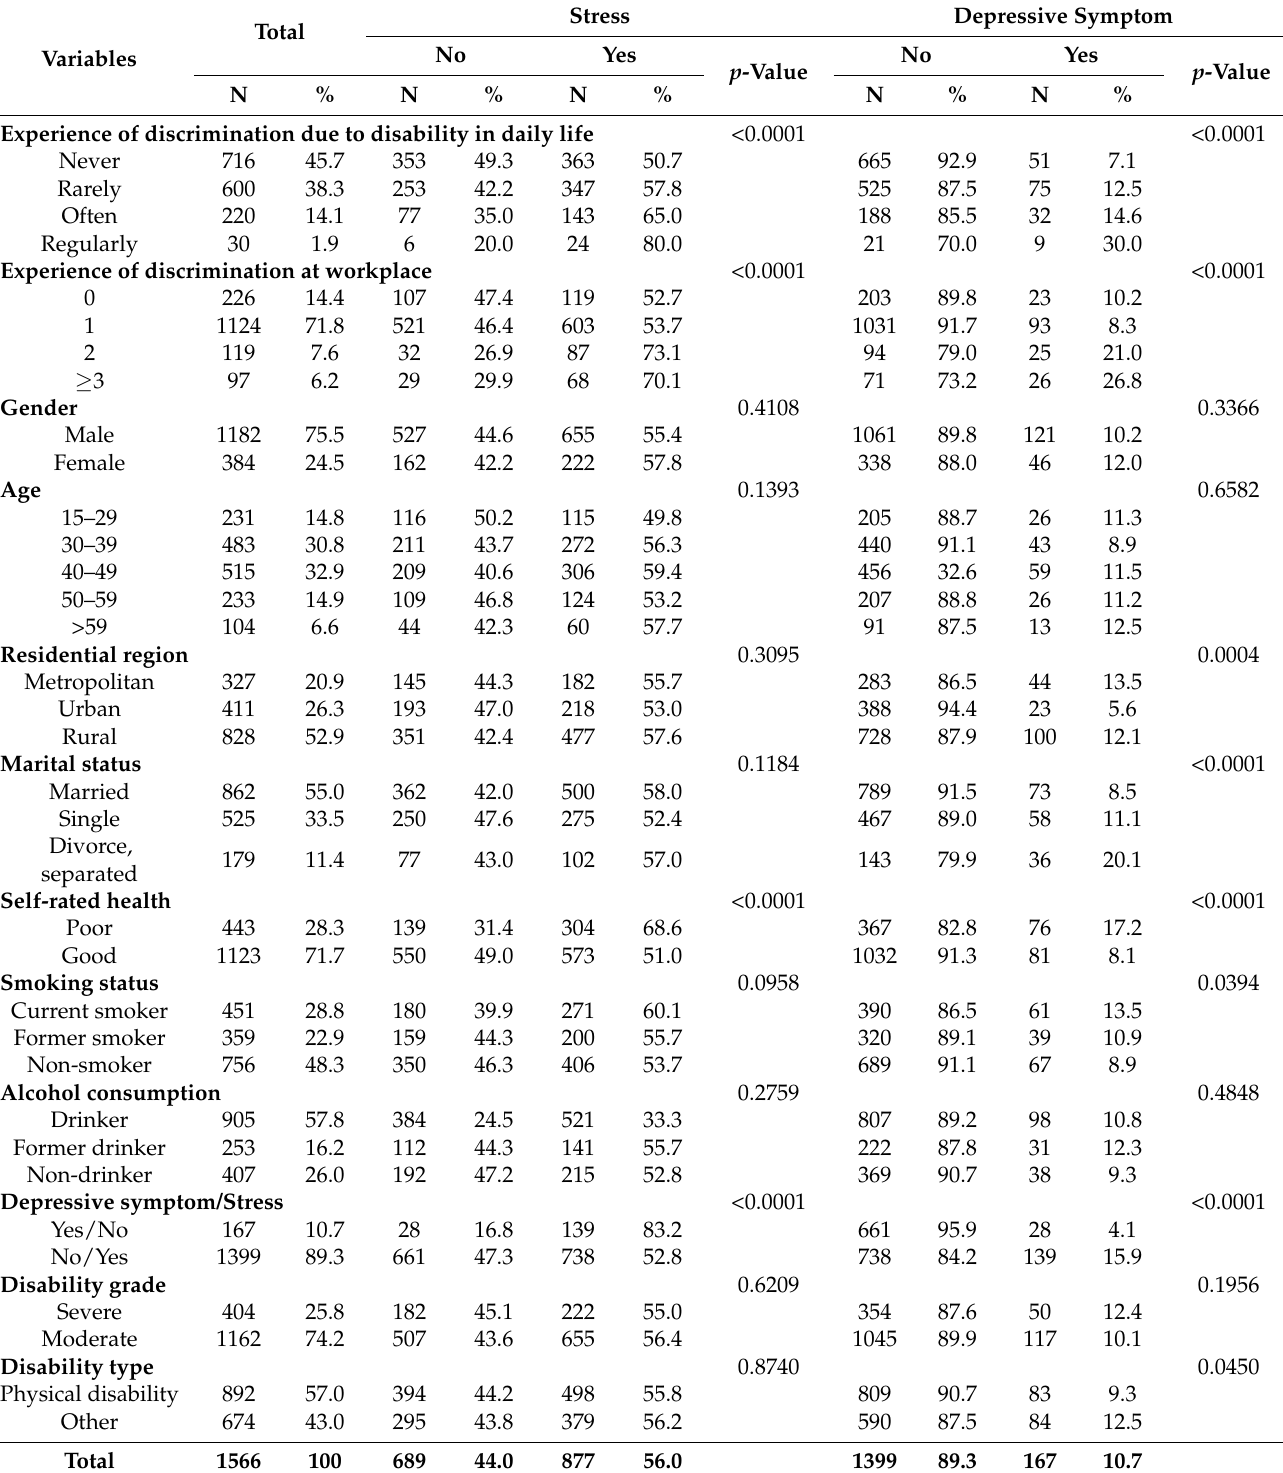
Table 1. General characteristics of study participants included for analysis at